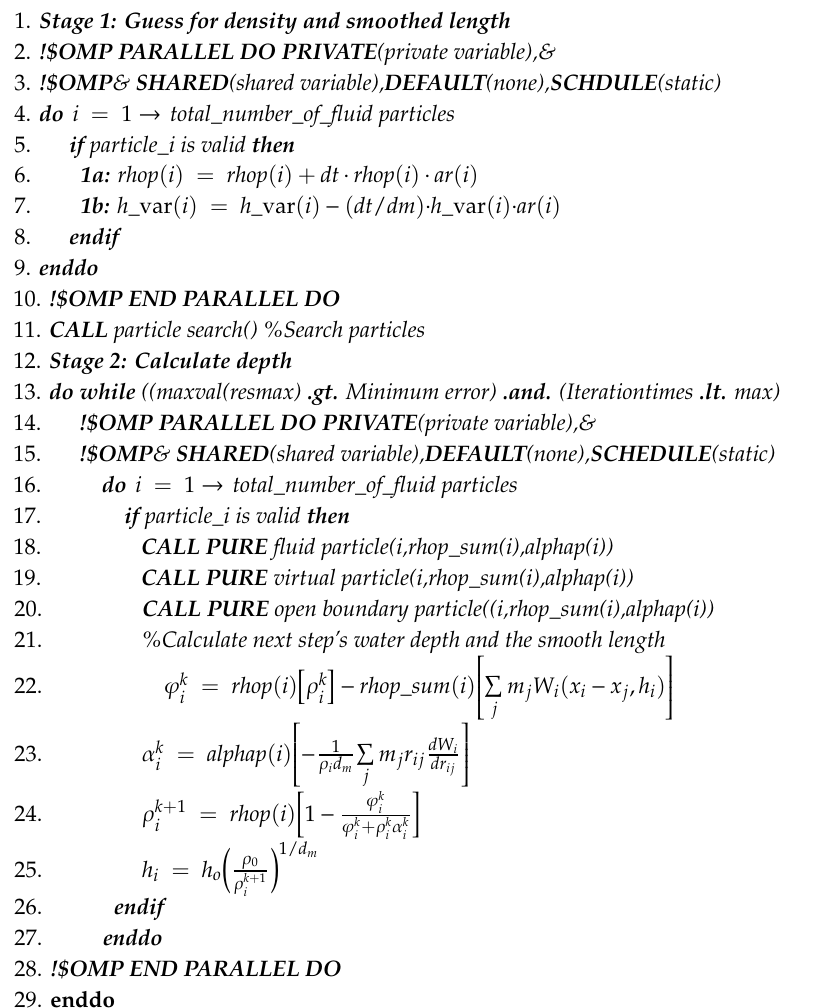
Algorithm 4 : Water depth